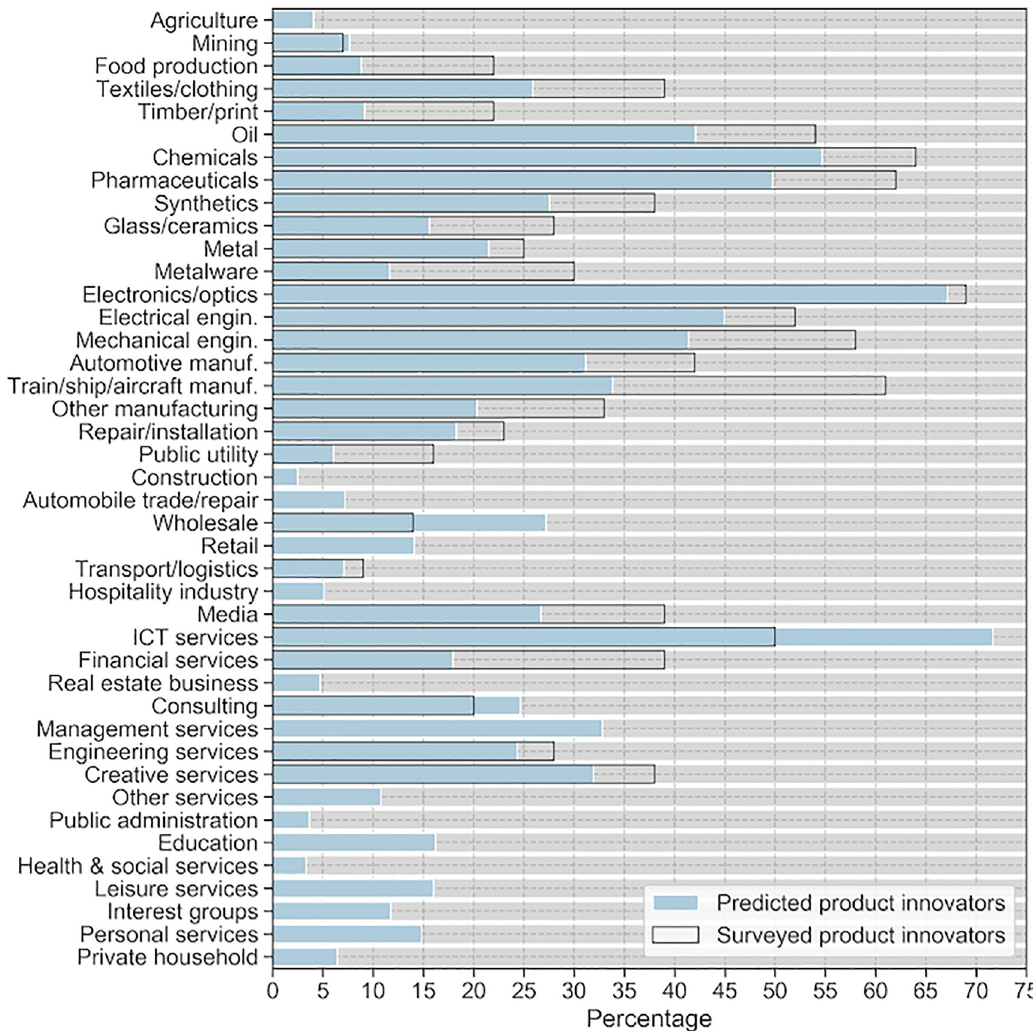
Fig 4. Predicted product innovator firms by sector. Share of product innovator firms with five or more employees by sector. Blue bars indicate the predicted shares. Transparent bars indicate extrapolated shares from the MIP innovation survey.